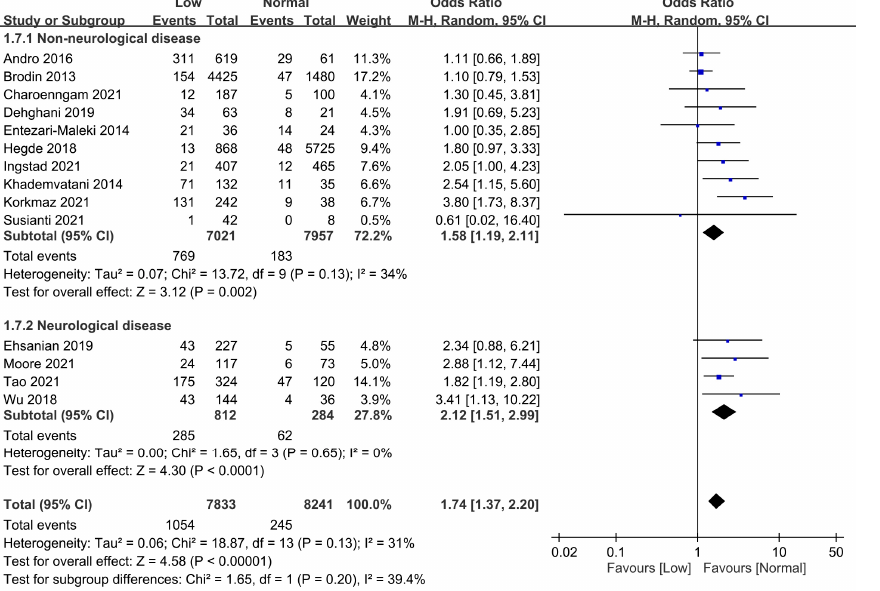
Figure 8. Subgroup analysis on the effect of the presence of neurological diseases (i.e., with vs. without neurological diseases) on the correlation between serum vitamin D level and the risk of venous thromboembolism. CI, confidence interval; M-H, Mantel-Haenszel. The measure of effect (e.g., an odds ratio) for each of these studies is represented by a square incorporating confidence intervals represented by horizontal lines. The vertical line is “Line of no effect”. The area of each square is proportional to the study’s weight in the meta-analysis. This meta-analysed measure of effect is plotted as a diamond, the lateral points of which indicate confidence intervals for this estimate